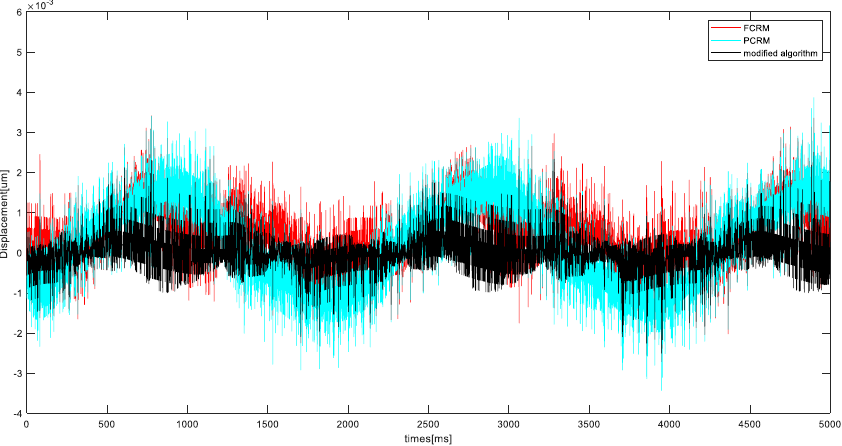
Figure 10. Error comparison of the modified model, FCRM, and PCRM when the frequency is 5 Hz.